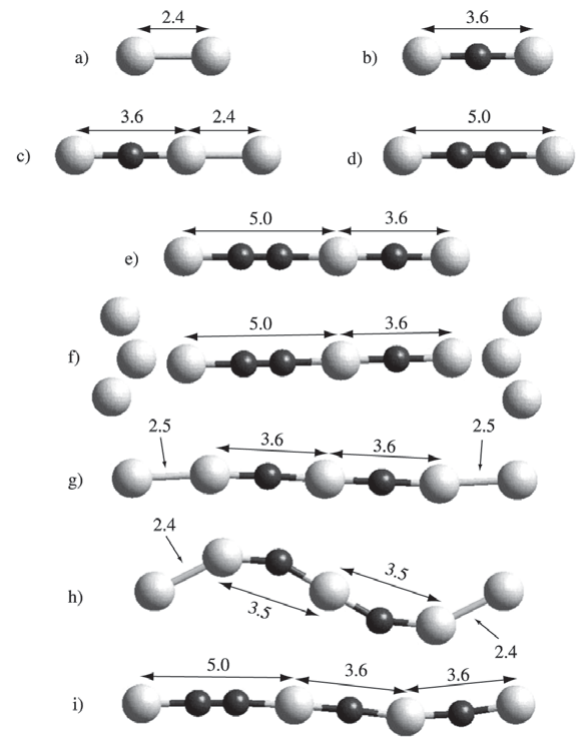
Figure 2. Optimized gold structures with carbon impurities, for selected configurations. In (a) is shown a gold dimer, with bond length in agreement with experimental data. The other chains in- corporate carbon impurities. In the different cases the optimized Au-Au distances are compatible with experimental values. The system in (f) is a gold-carbon chain with suspended tips at the ends. We can observe in (c), (g), and (h) situations where the pres- ence of carbon impurity does not affect the bond length of carbon- free Au-Au. Only the structure in (h) had its ends fixed, while all the other were free to